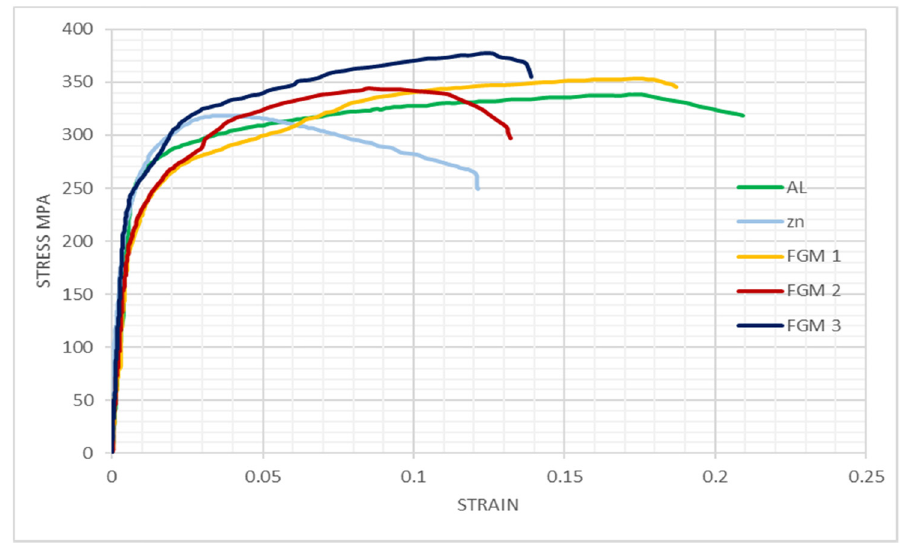
Figure 11: Stress – strain curves and behavior of